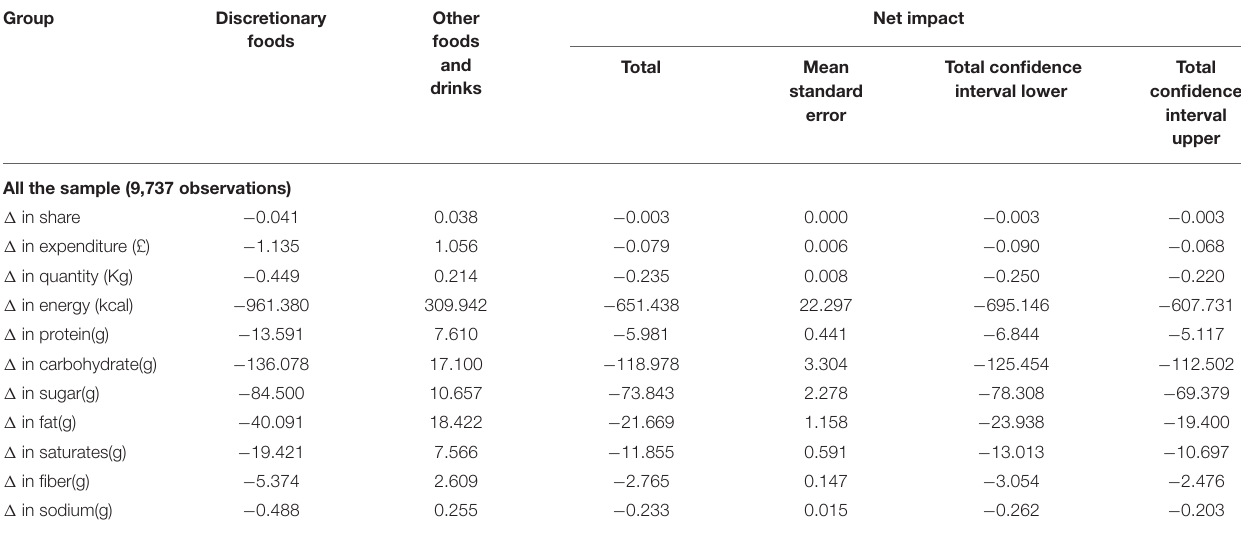
TABLE 3 | Net results of the simulation on discretionary foods (Changes are in per capita per week terms).